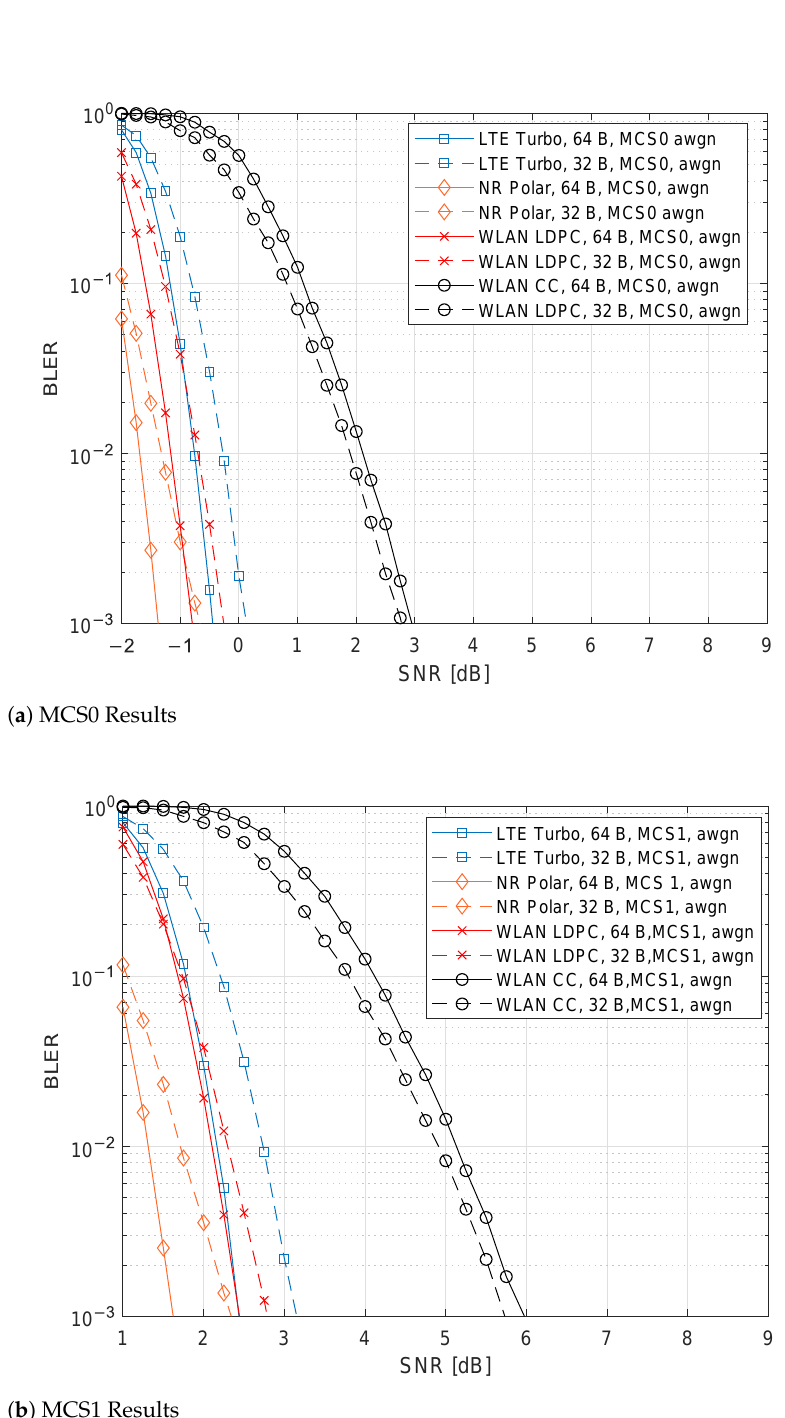
Figure 7. Comparison of the different channel coding techniques for AWGN